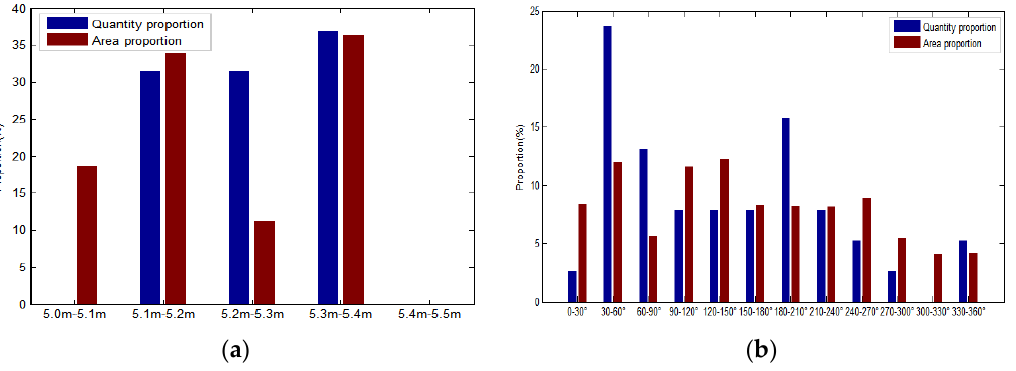
Figure 9. Interval distribution of the karst pore structure: ( a ) depth direction and ( b ) circumferential direction .